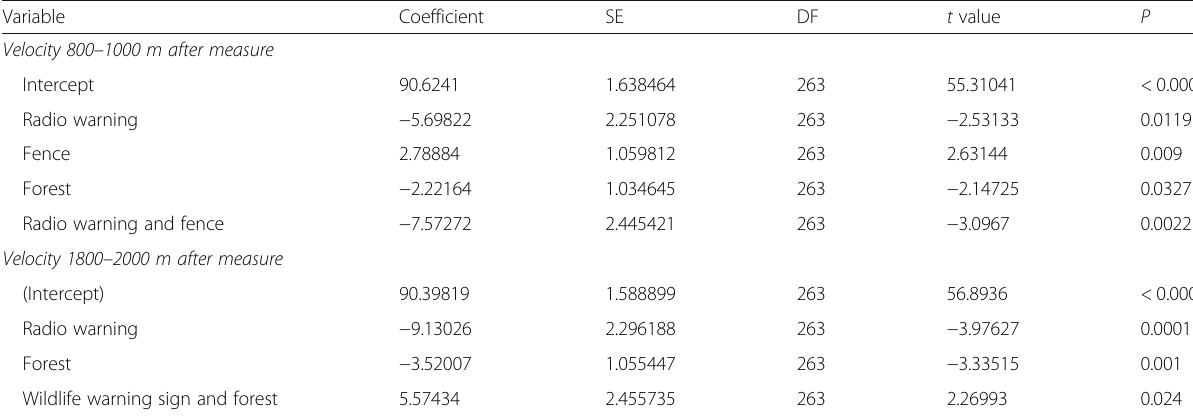
Table 4 Results of linear mixed-effects (LME) model explaining response variables in the driving simulator experiment by testing the effects of different animal-vehicle collision countermeasures (radio warning, wildlife warning sign, automatic speed camera) and the presence and absence of wildlife fence and dense forest versus open landscape